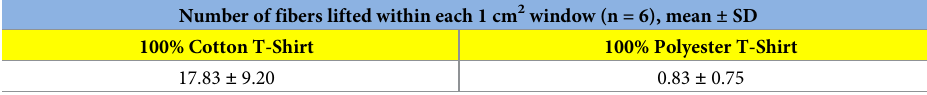
Table 7. Summary of tape lift sheddability data for the tested